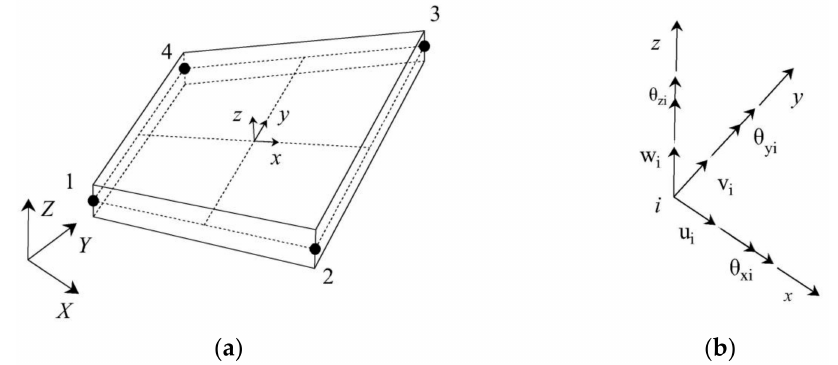
Figure 1. ( a ) The iQS4 inverse element and its ( b ) local nodal degrees of